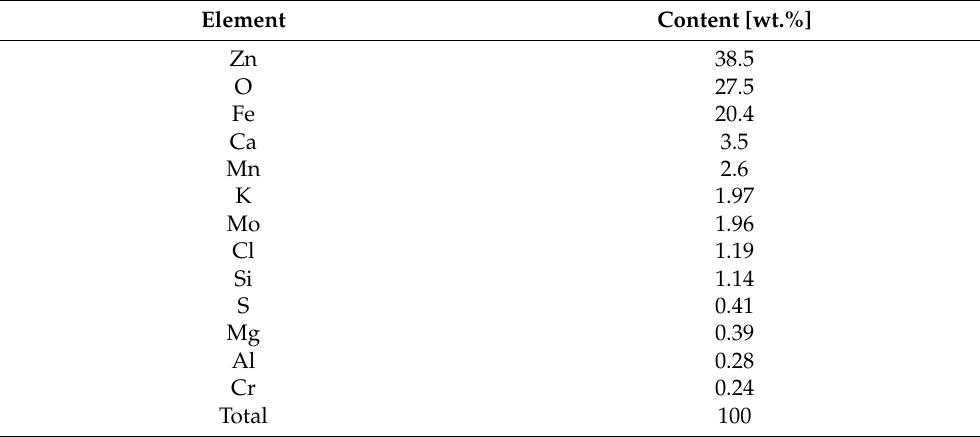
Figure 19. SEM-EDS image of EAFD before leaching, with the chemical composition and the coloured map of the elements in the examined area. Table 3. The chemical composition of the elements in the examined area.